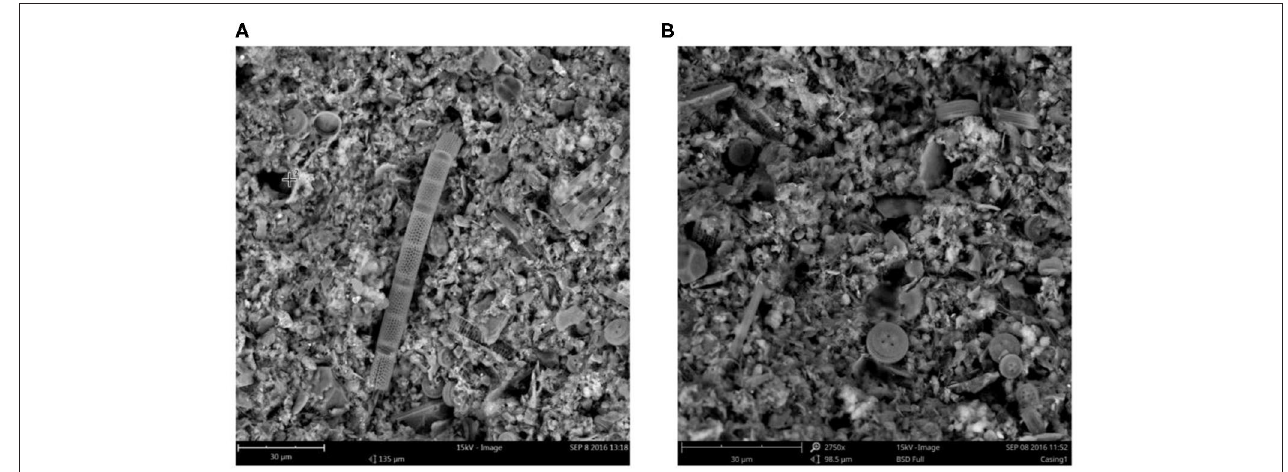
FIGURE 8 | SEM images (A,B) of biofilm samples collected at LBIS 1 showing diatoms imbedded in the biofilm